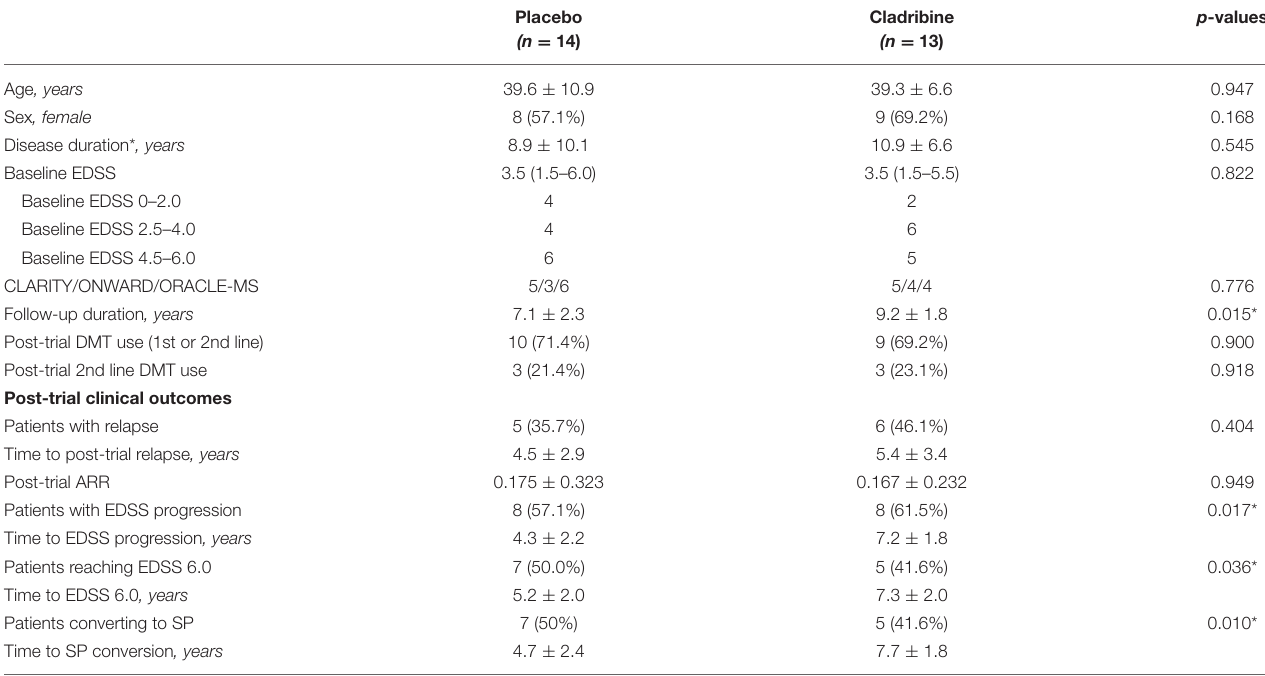
TABLE 1 | Demographic and clinical